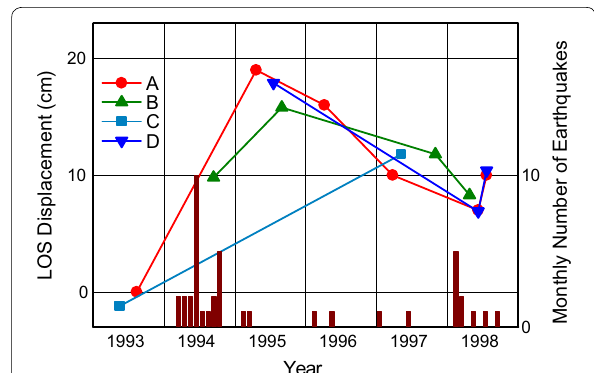
Fig. 3 Temporal evolution of the maximum LOS displacement in each interferogram near the center of the deformation field. Positive values show upward and/or east-southeastward displacement. Each time series A – D shows independent time change defined in Table 1. In this figure, each time series is shifted vertically to show the smallest variation between the time series. The monthly number of earth- quakes within the region (Fig. 2) is also plotted (Earthquake Research Institute 2002), including earthquakes with magnitudes of larger than 0.3 and depths of shallower than 20